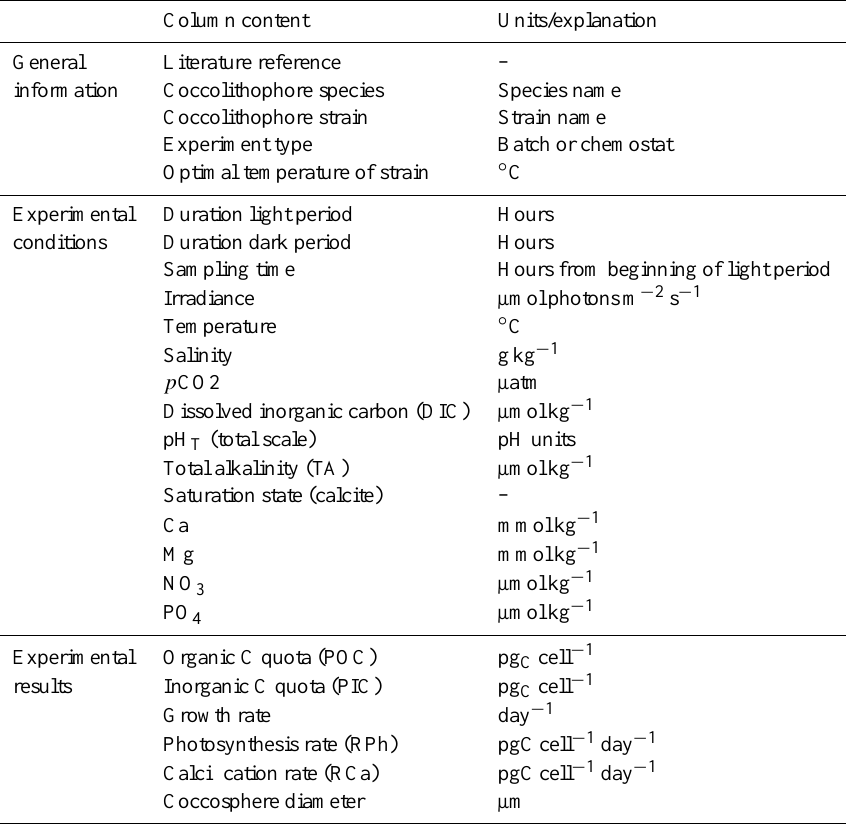
Table 1. Entries in the database of coccolithophore